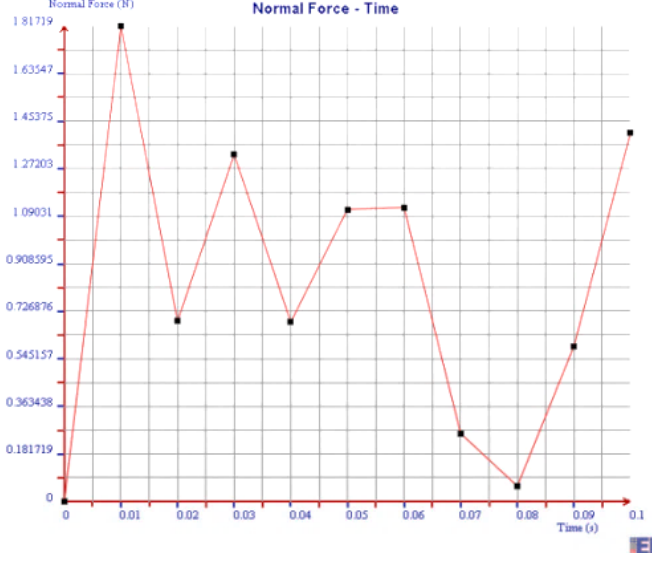
Figure 20. Normal force of 2 mm chromium balls.